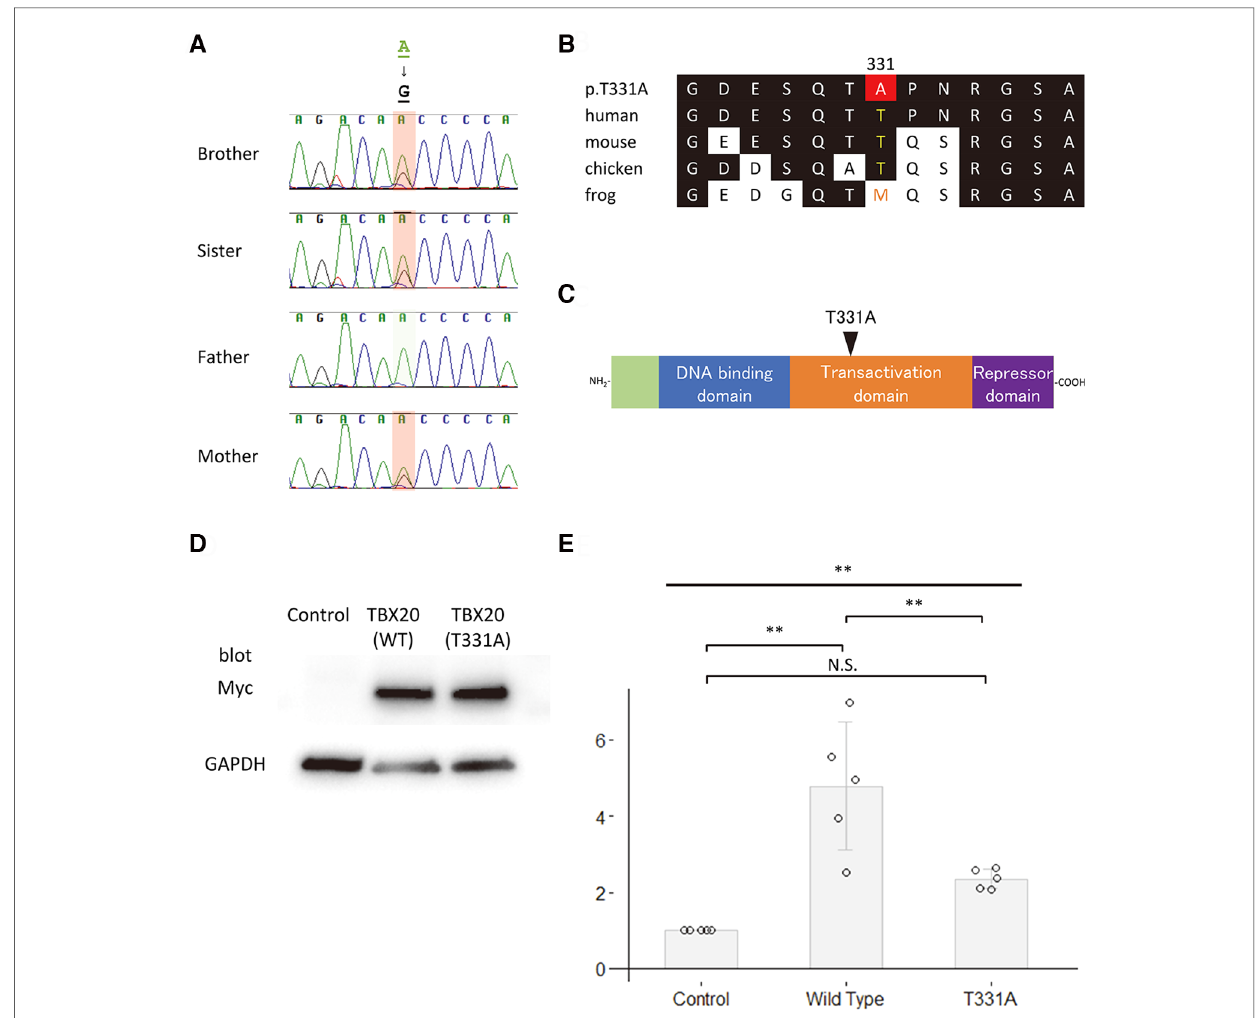
FIGURE 3 Functional analyses of TBX20 . ( A ) Sequence chromatograms of TBX20 in the family. ( B ) The conservation of alignment of the variant in the coding regions between species. Changes in amino acids are highlighted in red. The position of T331 is well-conserved between species. ( C ) Structure of the human TBX20 protein. The position of the variant is indicated by an arrowhead. ( D ) Western blot analysis of the c-Myc-tagged wildtype TBX20 and the variant TBX20 (p.T331A) proteins. Glyceraldehyde-3-phosphate dehydrogenase, GAPDH, is used as an internal control. ( E ) Fold increase in relative luciferase activity in HeLa cells transfected with green fl uorescent protein as control, wildtype TBX20 or variant TBX20 (p.T331A) expression construct, and NPPA -Luc ( N =5). All values are expressed as the mean±SD. Signi fi cance was assessed using one-way ANOVA, followed by Tukey ’ s post hoc test. **, p <0.01; N.S., not signi fi